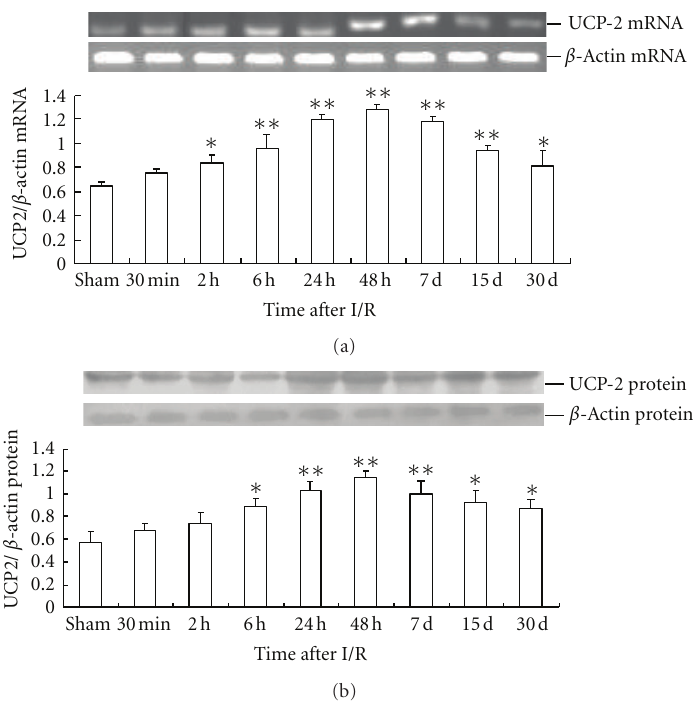
Figure 3: Time-dependent expression of UCP2 in global cerebral I/R rat hippocampus ( n = 4). (a) The relative mRNA level of UCP2 was normalized to endogenous β -actin mRNA for each sample. (b) The relative protein level of UCP 2 was normalized to endogenous β -actin protein for each sample. Dates are expressed as mean ± SD of four individual experiments. ∗∗ P < 0 . 01 compared with sham group, ∗ P < 0 . 05 compared with sham